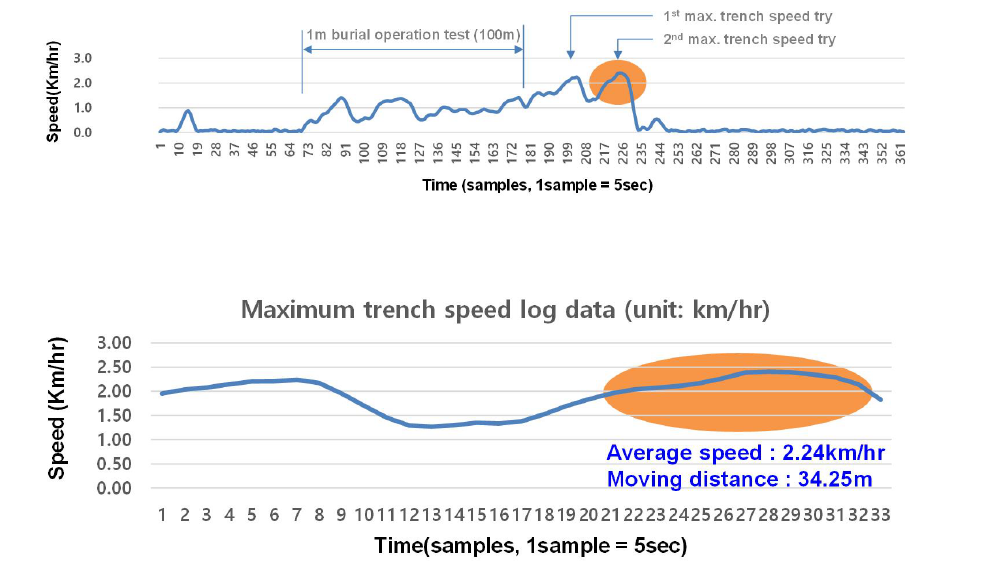
Figure 16. Verification of 2 km/h of maximum trench